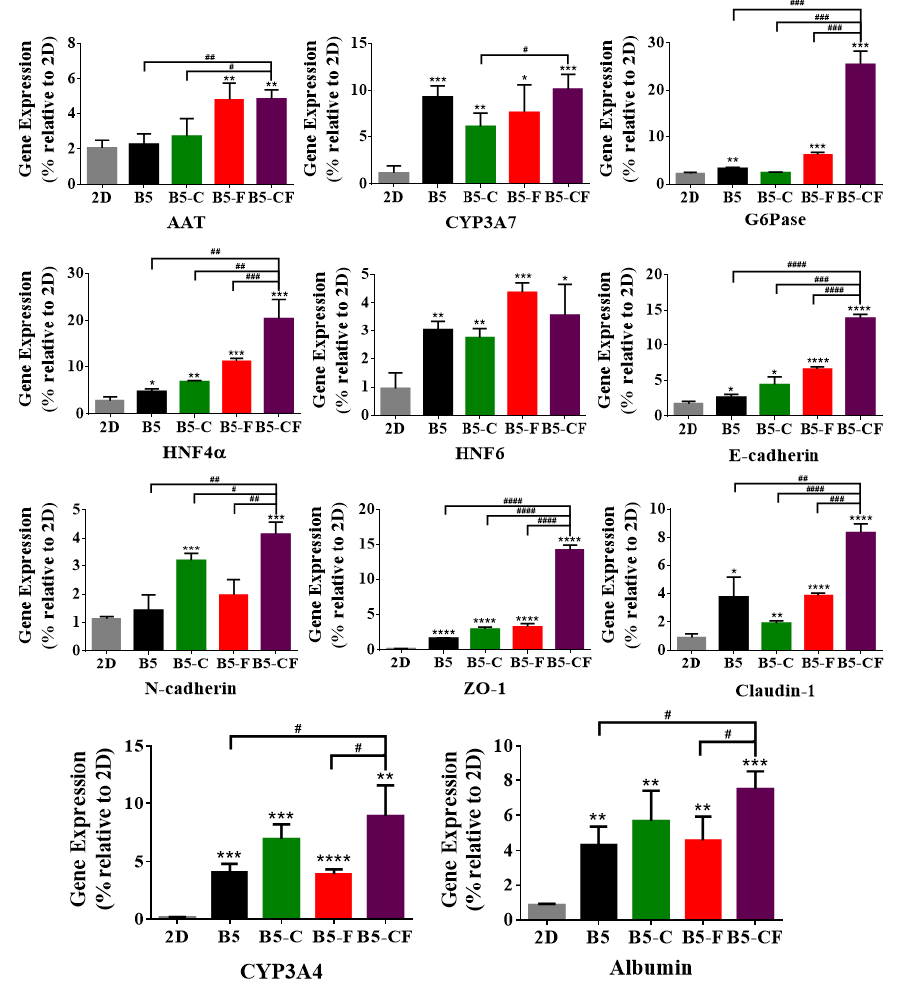
Figure 9. Effect of HepG2 cell culture in 3D BSAMA cryogels and on 2D substrates on liver-specific gene expression at day 14. HepG2 cells were cultured in 3D and 2D culture systems, and their RNA was extracted for the quantitative real-time PCR analysis of AAT, CYP3A7, G6Pase, HNF4 α , HNF6, E-cadherin, N-cadherin, ZO-1, claudin-1, CYP3A4, albumin. The data were normalized to the housekeeping gene GAPDH. ( n = 3, *: p < 0.05, **: p < 0.01, ***: p < 0.005, ****: p < 0.001, compared to 2D culture. #: p < 0.05, ##: p < 0.01, ###: p < 0.005, ####: p < 0.001, between the samples at